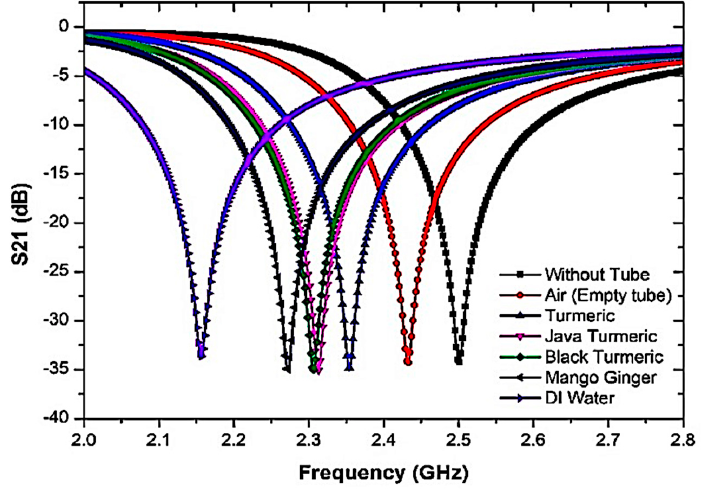
Figure 10. The frequency response of triple-rings CSRR sensor with the presence of SUT samples.